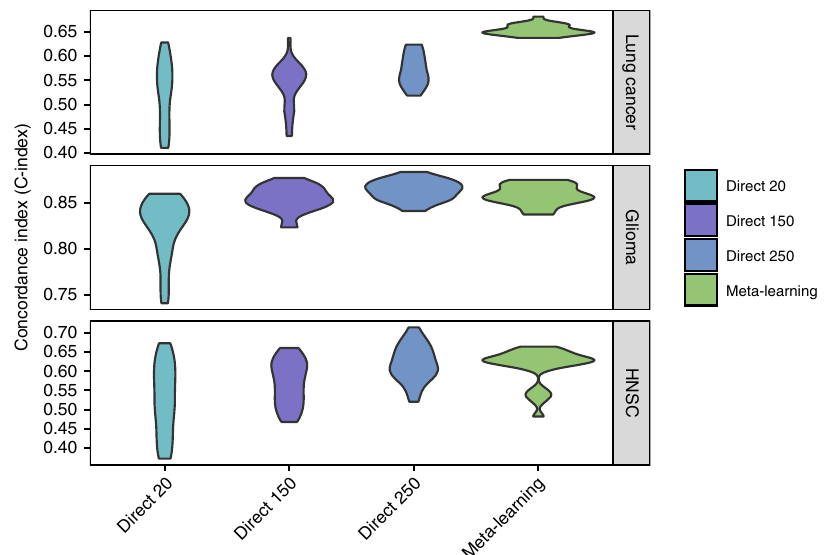
Fig. 4 C-Index for target cancer survival prediction, comparing direct learning with large (250), medium (150), and small (20) size samples and meta- learning. The fi gure shows results for lung cancer (top panel), glioma (middle panel), and head and neck cancer (bottom panel).